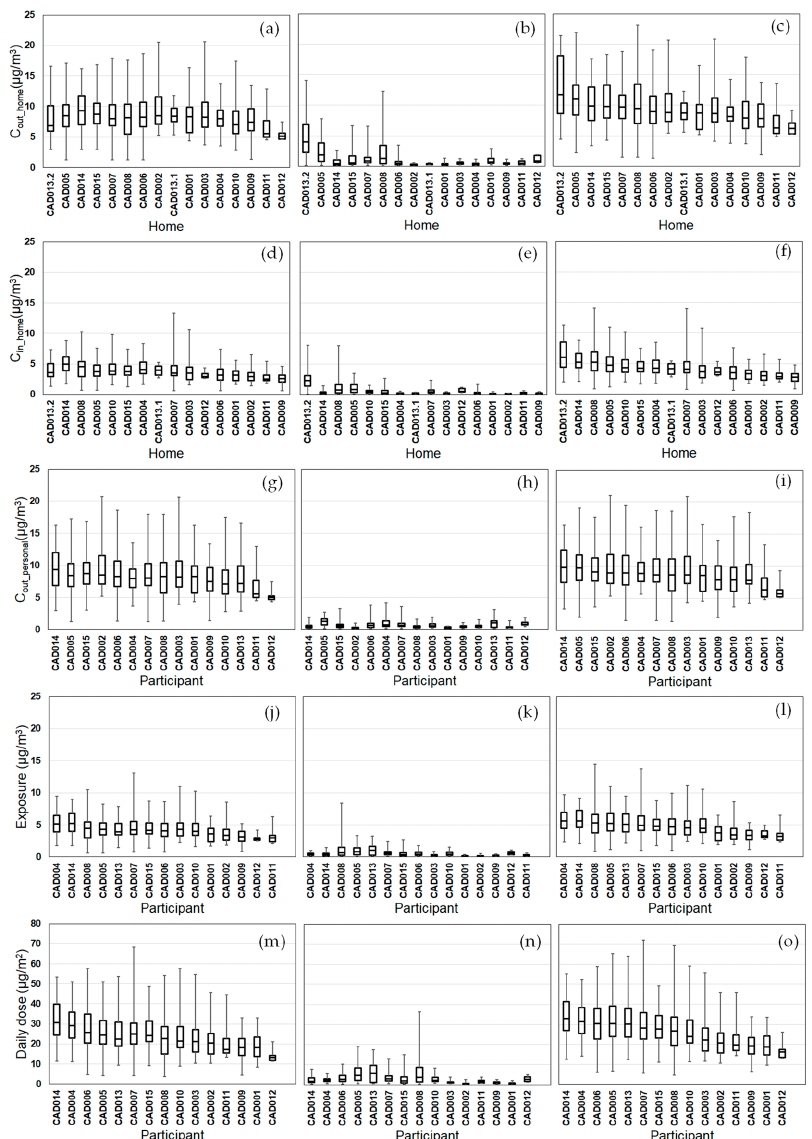
Figure 2. Modeled PM 2.5 exposure metrics for Tier 1 (outdoor home concentrations; a – c ), Tier 2 (indoor home concentrations; d – f ), Tier 3 (personal outdoor concentrations; g – i ), Tier 4 (exposures; j – l ),